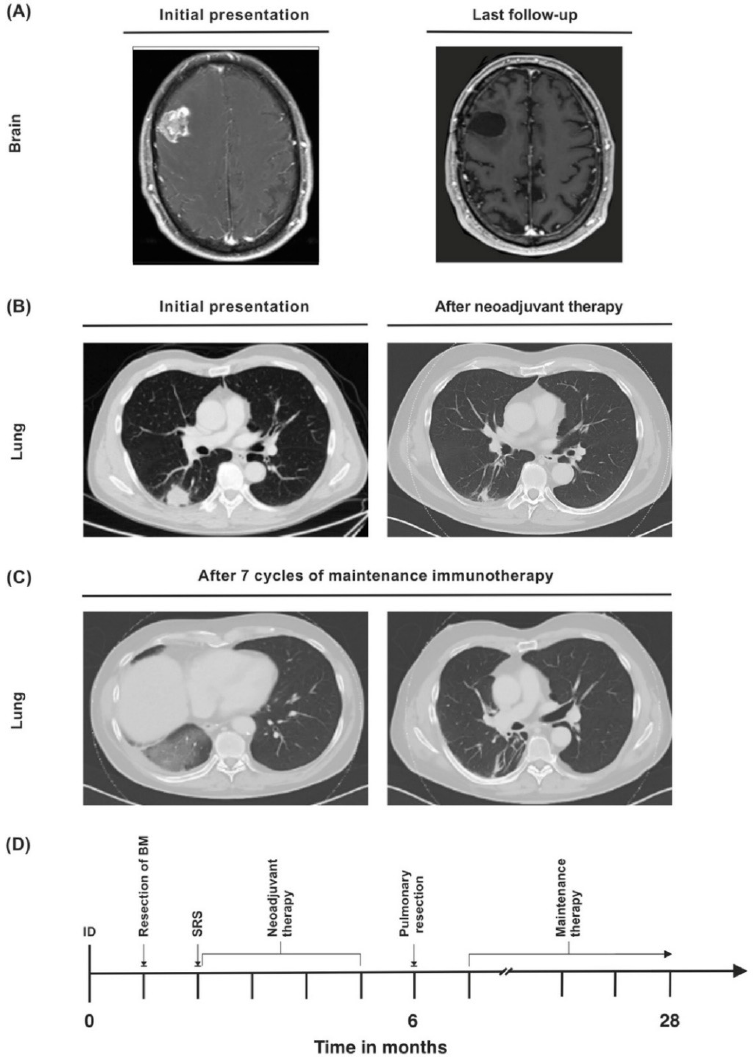
Figure 3. ( A ) Synchronous cerebral metastasis at baseline and upon last follow-up. ( B ) Primary lung tumor at initial diagnosis and after neoadjuvant therapy. ( C ) Lung infiltrations in the right lung that were attributed to immunotherapy-associated pneumonitis were detected during maintenance therapy. ( D ) Timeline of the patient’s treatment course. ID = initial diagnosis.